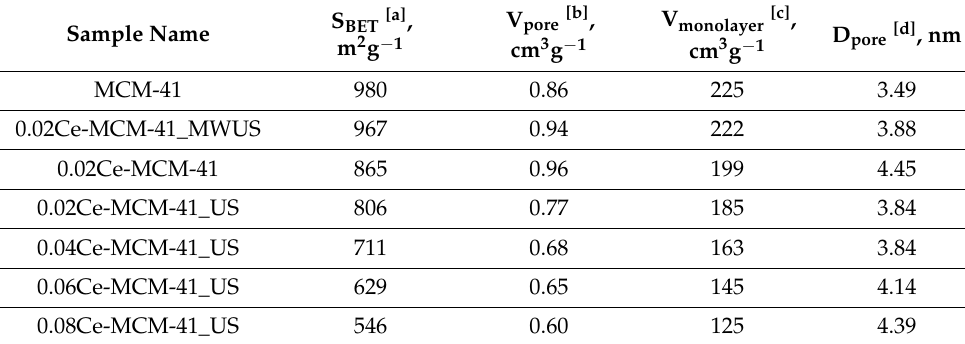
Table 2. Textural properties for Ce- modified mesoporous